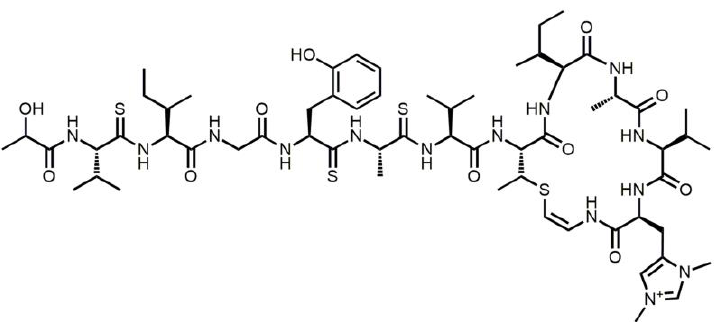
Figure 1. Thioalbamide structure.